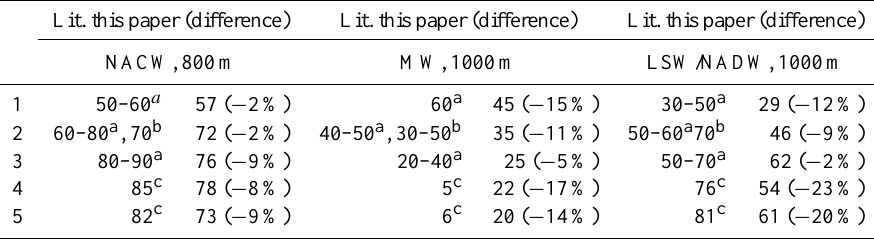
Table A1. A comparison of percentages obtained by applying the OMP analysis. The column “Lit.” shows the range of percentages of a source water type in a literature source, the definitions of source water types characteristics from which are used to derive source water types characteristics for this study. The difference is computed between the mean values in a 5 ◦ × 5 ◦ square (Fig. A1) between a literature source and this